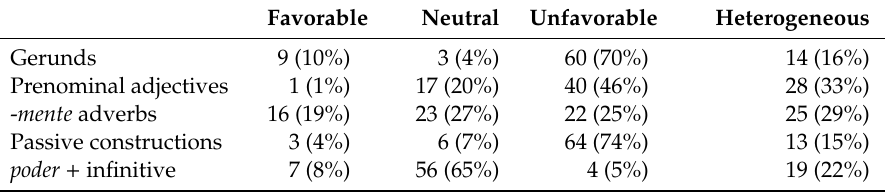
Table 1. Students’ responses on general instructor attitudes ( N =